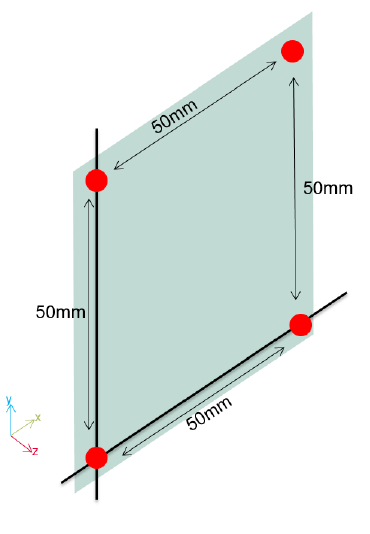
Figure 3. Position of the ultrasonic